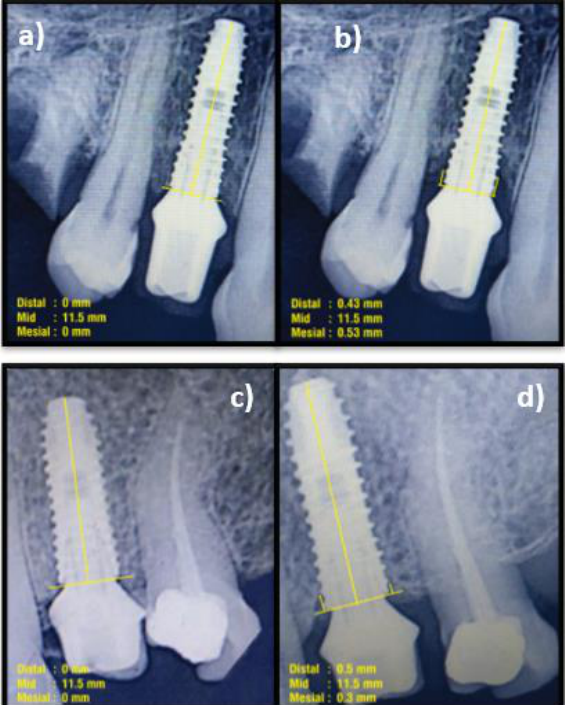
Figure 4. Measurement of marginal bone loss (MBL). ( a ) Immediately post-functional loading (Con- trol); ( b ) 1-year post-functional loading (Control); ( c ) Immediately post-functional loading (test); ( d ) 1-year post-functional loading (Test).